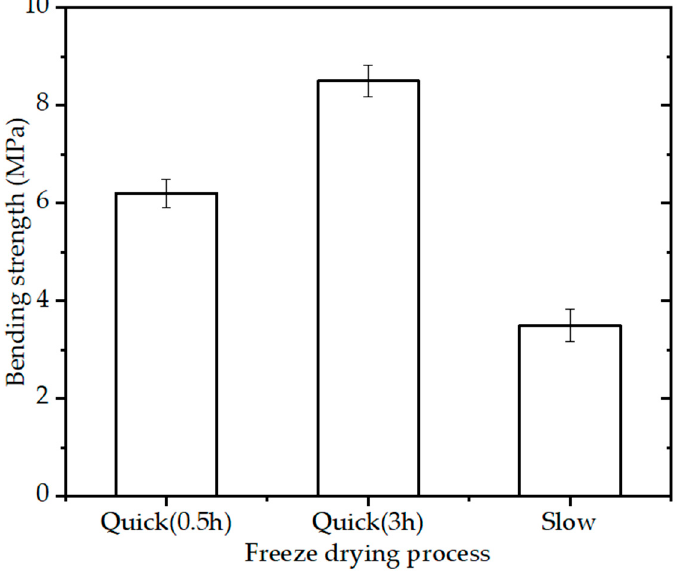
Figure 5. Bending strength of the BINs with different freeze-drying processes after one-step sintering at 1200 °C for 3 h ( p < 0.05).